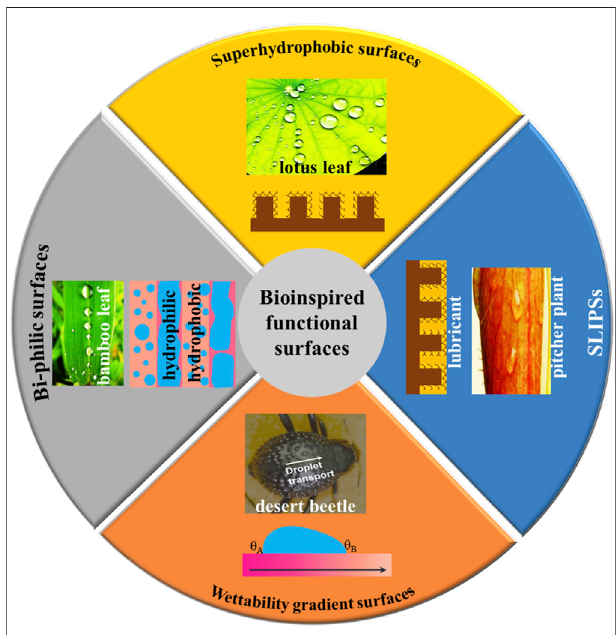
FIGURE 1 | Bioinspired functional surfaces for dropwise condensation heat transfer